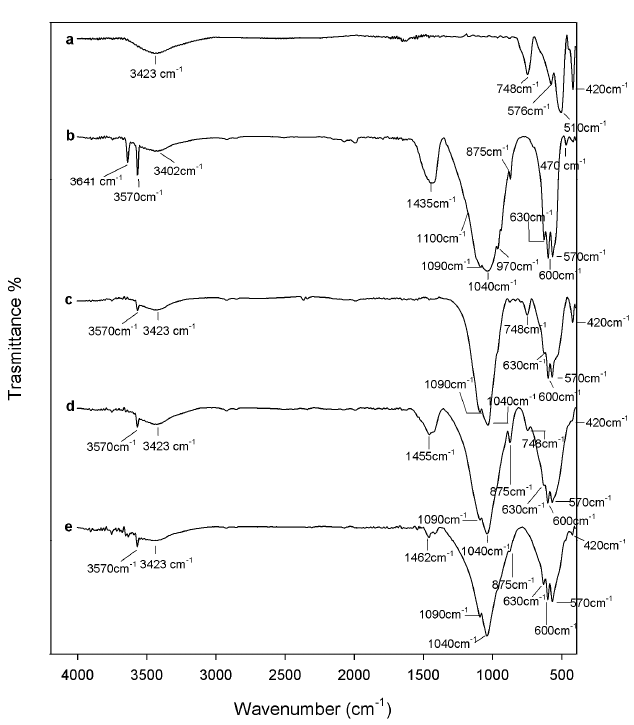
Figure 3. FTIR of ( a ) ZrO 2 ; ( b ) Hap; ( c ) 9ZrO 2 ·1Hap; ( d ) 7ZrO 2 ·3Hap; and ( e ) 5ZrO 2 ·5HAp gels, heated to 1000 °C.